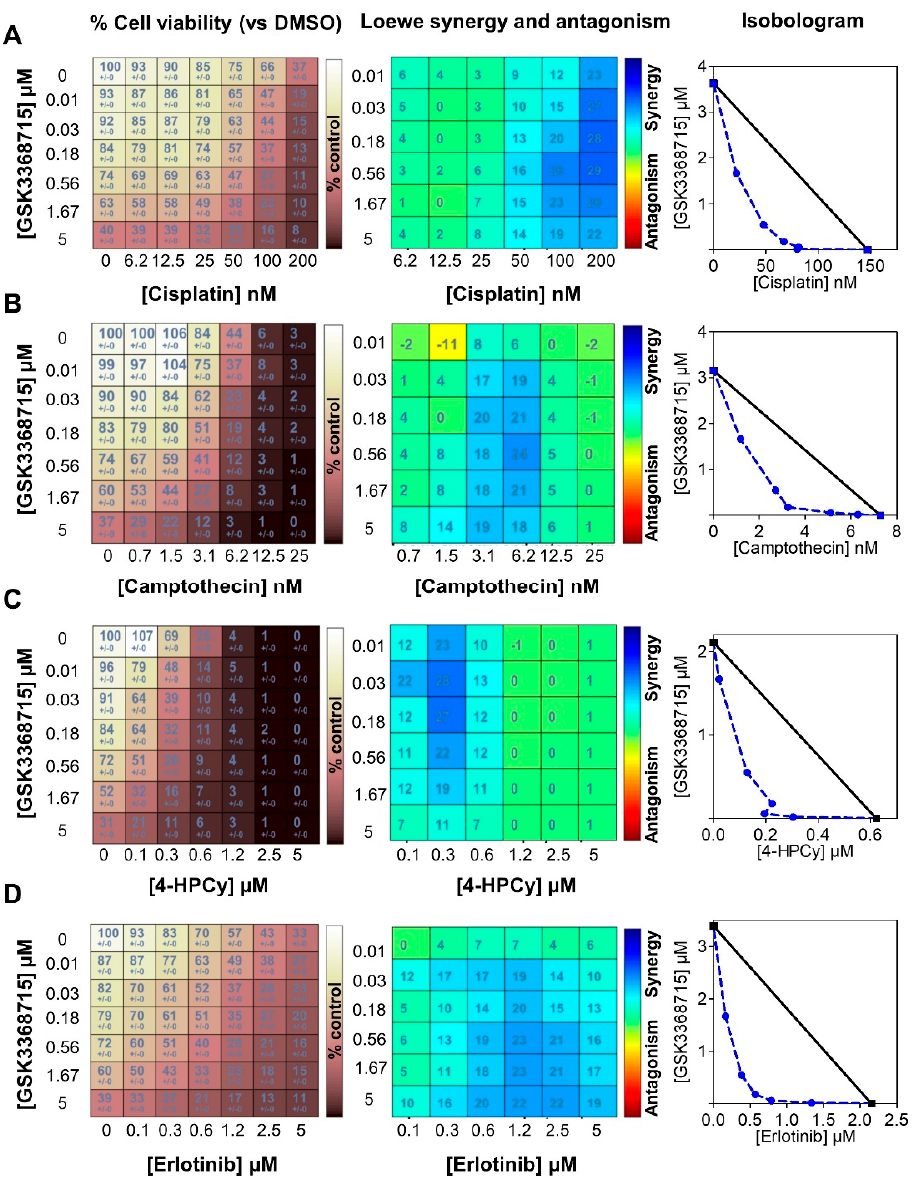
Figure 6. Synergistic interactions between GSK3368715 (a type I PRMT inhibitor) and chemotherapies ( A – C ) or erlotinib ( D ). MDA-MB-468 cells were seeded in 96-well plates, treated with the indicated drugs for 7 days (equivalent to four doubling times), and cell viability was measured by CellTiterGlo assay. GSK3368715 was serially diluted three-fold and cisplatin ( A ), camptothecin ( B ), 4-hydroperoxy cyclophosphamide (4-HPCy; ( C )), erlotinib ( D ) were serially diluted two-fold (concentrations indicated in the figure). The drug interactions were calculated using the Loewe model on the Combenefit software. Cell viability (% compared to DMSO-treated cells, left panel ), synergy matrix as calculated using the Loewe excess model ( middle panel ), and isobolograms ( right panel ) for each drug pair are indicated. Presented data are representative of three independent experiments.